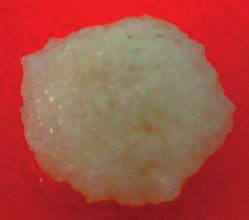
Figure 11. The shape of TKP2 matrix tablet after 12 h of in vitro dissolution.